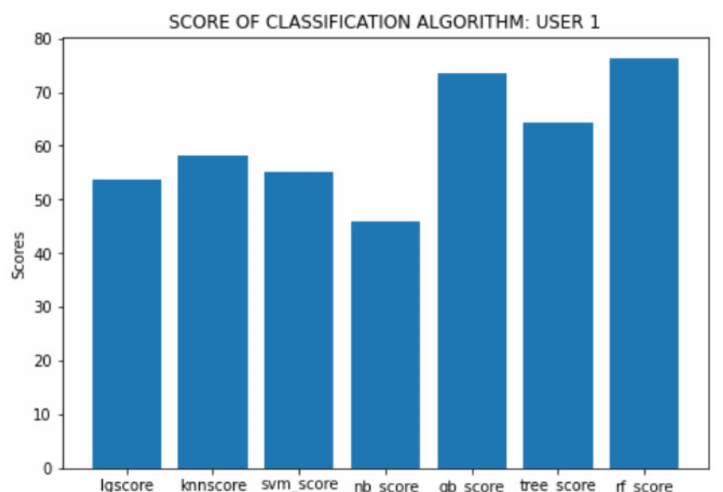
Figure 5. Classifier Scores to predict the labeled